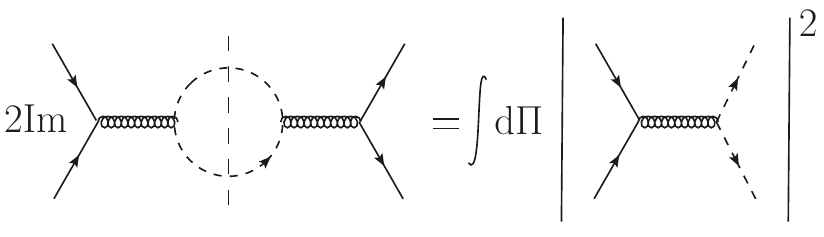
Figure 1 . Processes involving the absorptive part of the graviton-multiplet